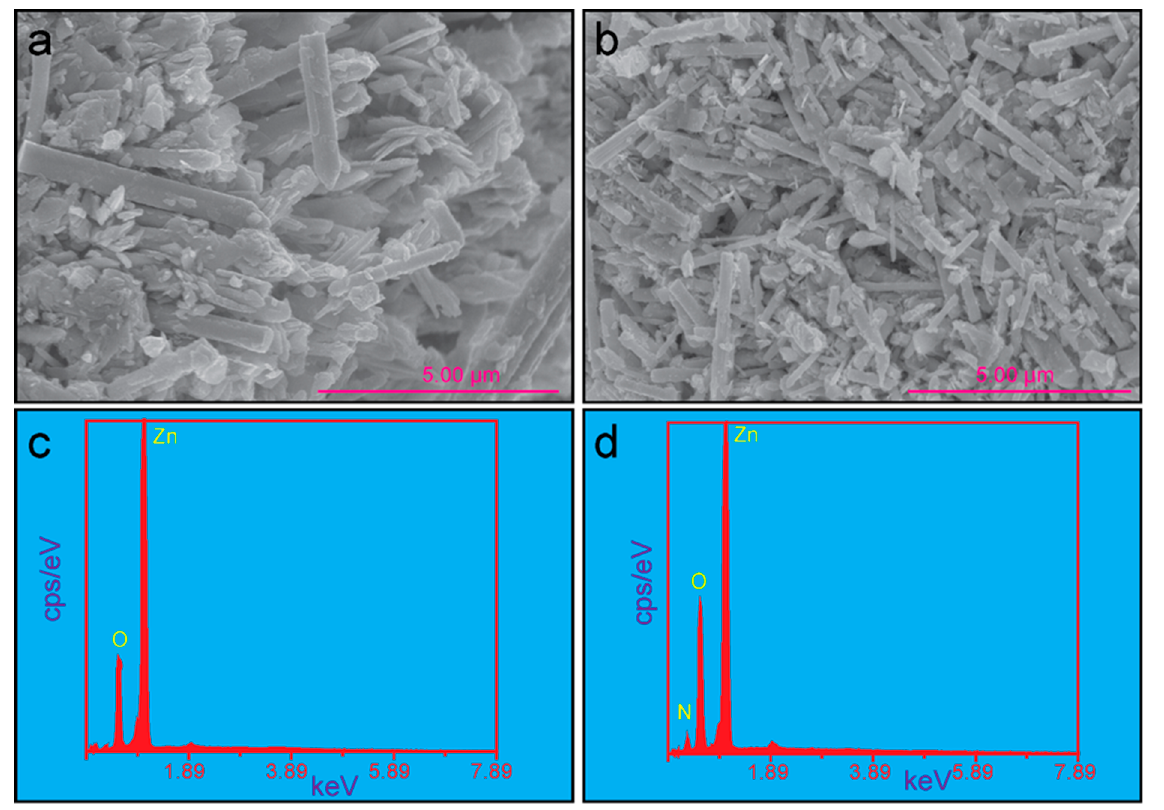
Figure 3. HR-FE-SEM images of ( a ) ZnO and ( b ) N-doped ZnO; ESD spectra of ( c ) ZnO and ( d ) N-doped ZnO.